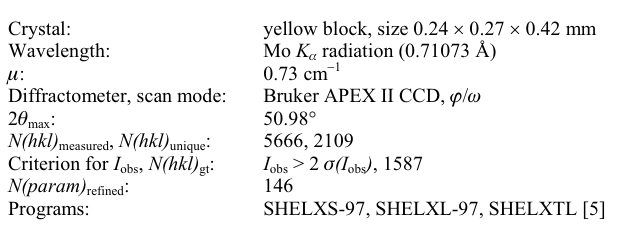
Table 1. Data collection and handling.